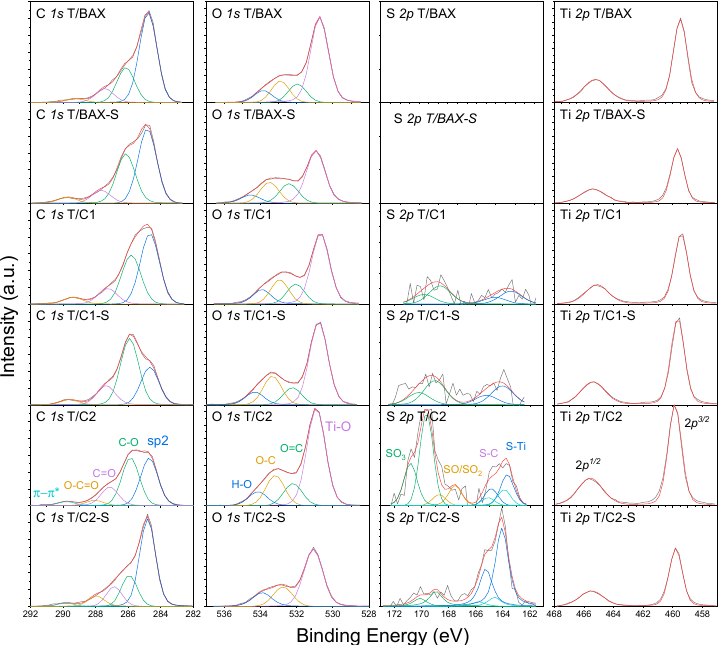
Figure 8. Deconvolution of C 1s, O 1s, S 2p and Ti 2p 3/2 core energy level spectra. In the case of S 2p, the 2p3 / 2 and 2p 1 / 2 contributions (di ff er by 1.19 eV) are marked with the corresponding